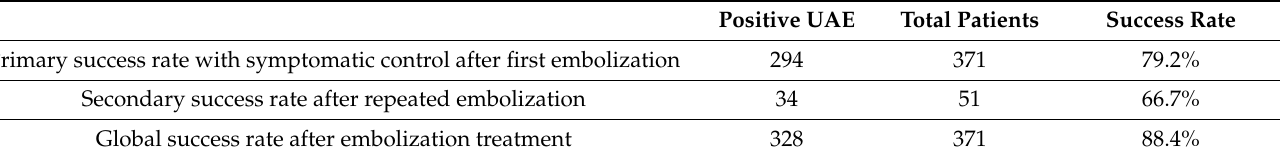
Table 3. Global success rate after first and repeated embolization treatment.